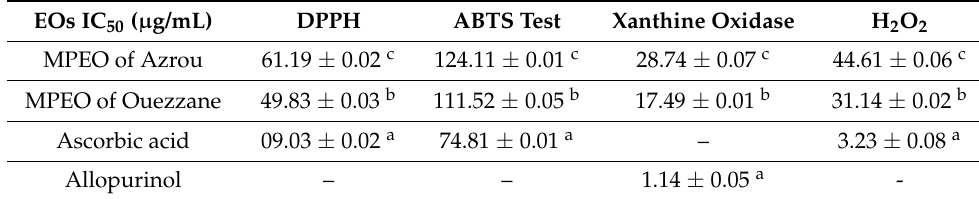
Table 2. Antioxidant effect of Mentha piperita